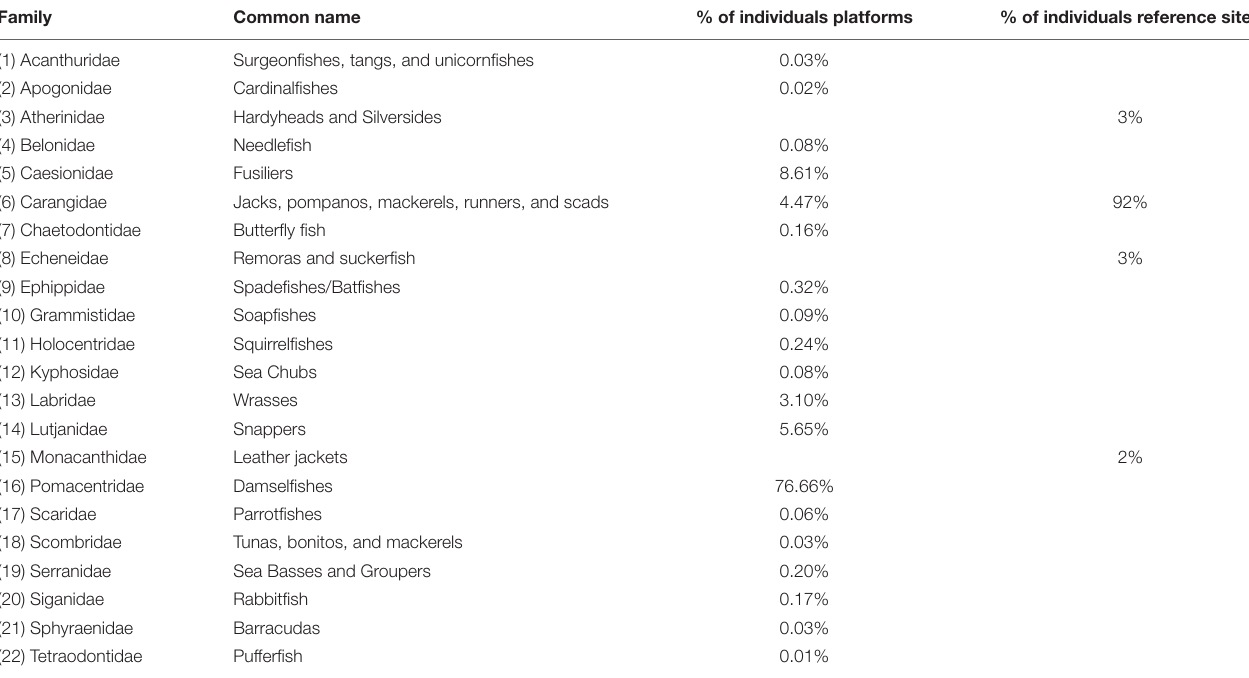
TABLE 3 | Fish families recorded at Platform and Reference sites.